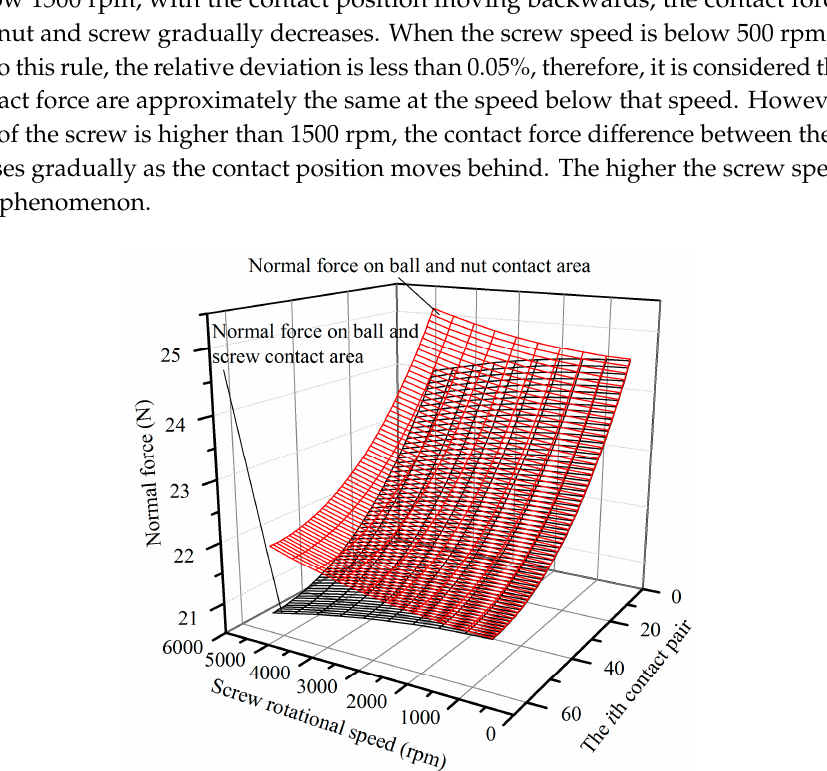
15 of 34 Table 1. Structure and size parameters of the SNBSP. Parameter